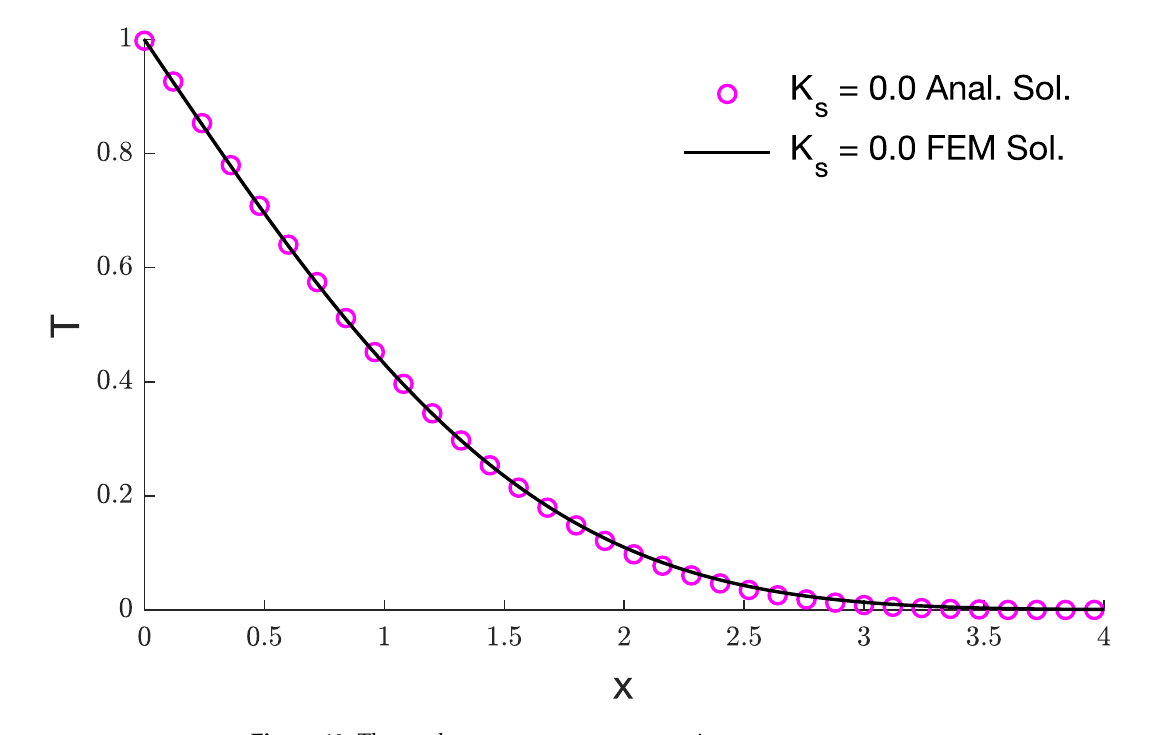
Figure 13. The study on temperature comparison.